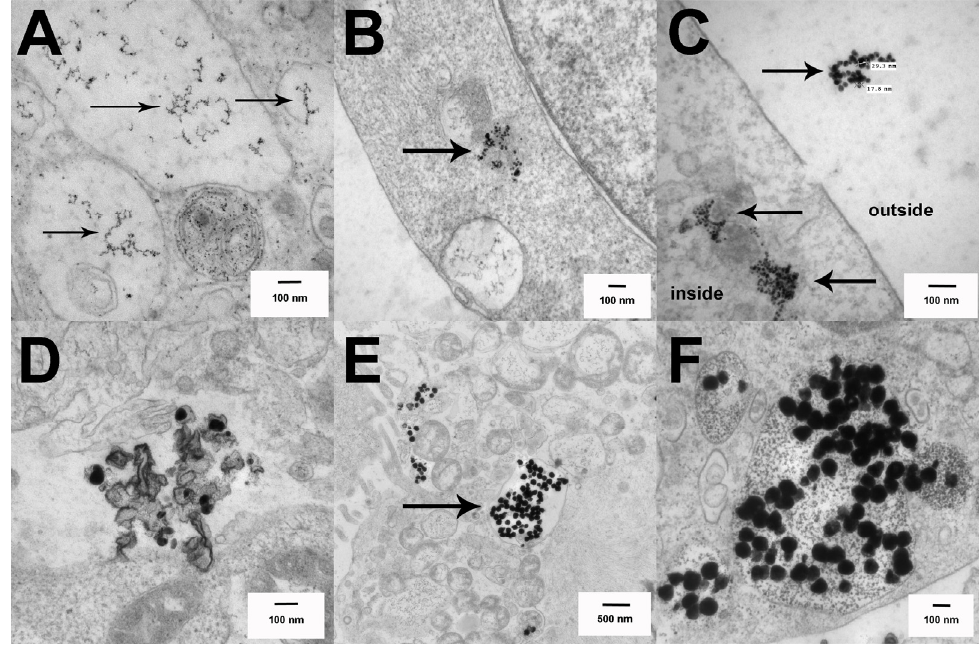
Figure 7. Uptake of citrate-stabilized Ag nanospheres in murine epithelial cell lines demonstrated by TEM imaging at 4 h post exposure. ( A ) LA4 cells exposed to 20 nm Ag nanospheres; ( B ) C10 cells exposed to 20 nm Ag nanospheres; ( C ) MLE12 cells exposed to 20 nm Ag nanospheres; ( D ) LA4 cells exposed to 110 nm Ag nanospheres; ( E ) C10 cells exposed to 110 nm Ag nanospheres; ( F ) MLE12 cells exposed to 110 nm Ag nanospheres. Arrows indicate areas of clustered Ag